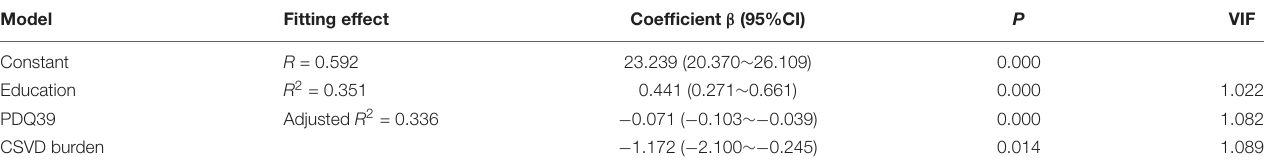
TABLE 2 | Multivariate linear regression analysis of factors associated with MoCA